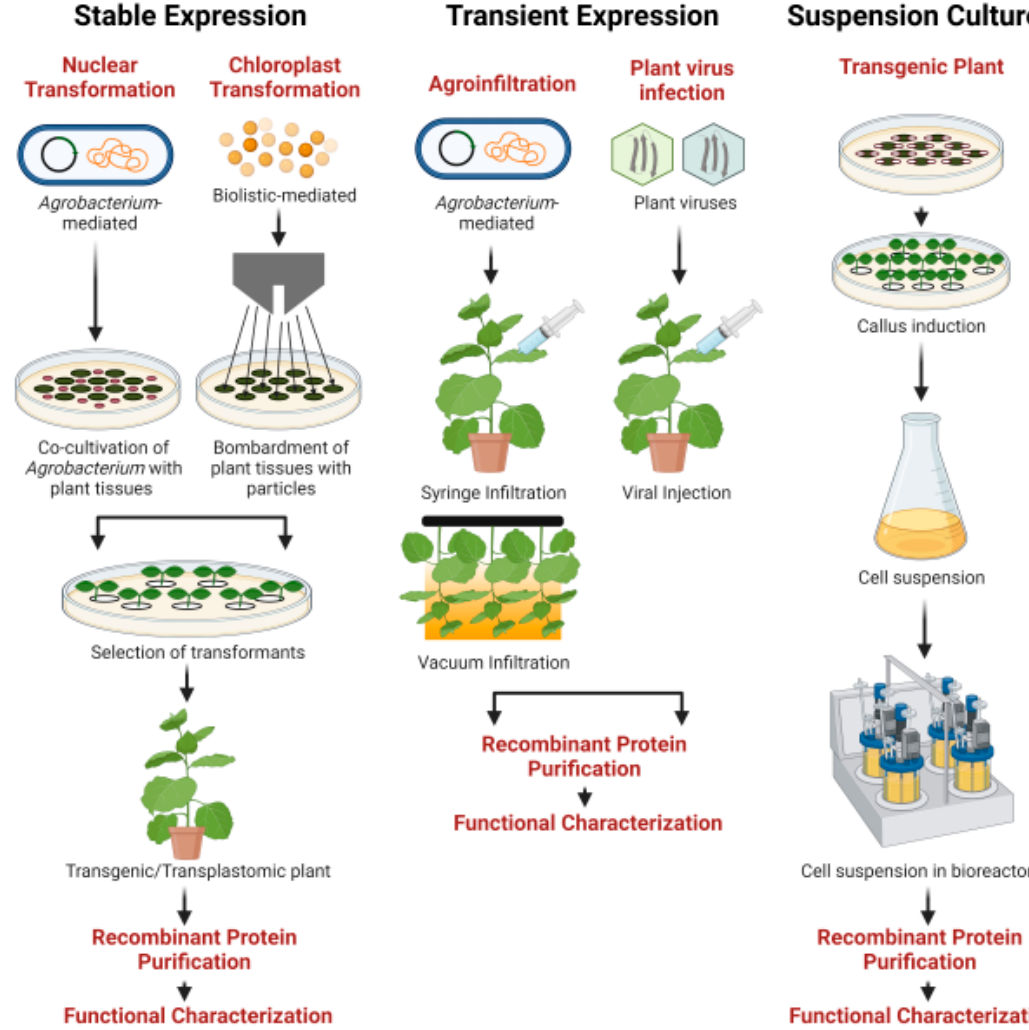
Figure 1. Schematic representation of technologies available in plant-based platforms for the production of recombinant biopharmaceuticals. During initial stages of plant molecular farming, recombinant protein expression in plants were based on stable expression in which the gene of interest is cloned into plant expression vector and transformed into plant nucleus/chloroplast either by Agrobacterium or biolistic mediated method to produce transgenic or transplastomic plants. Transient expression combines the advantages of A. tumefaciens and plant viral elements for the rapid and high yield protein production. Genetically modified suspension-cultured plant cells integrate the advantages of whole-plant systems with those of bacterial fermentation and mammalian cell cultures. Suspension cultures can be grown in bioreactors under controlled environment for recombinant protein production.